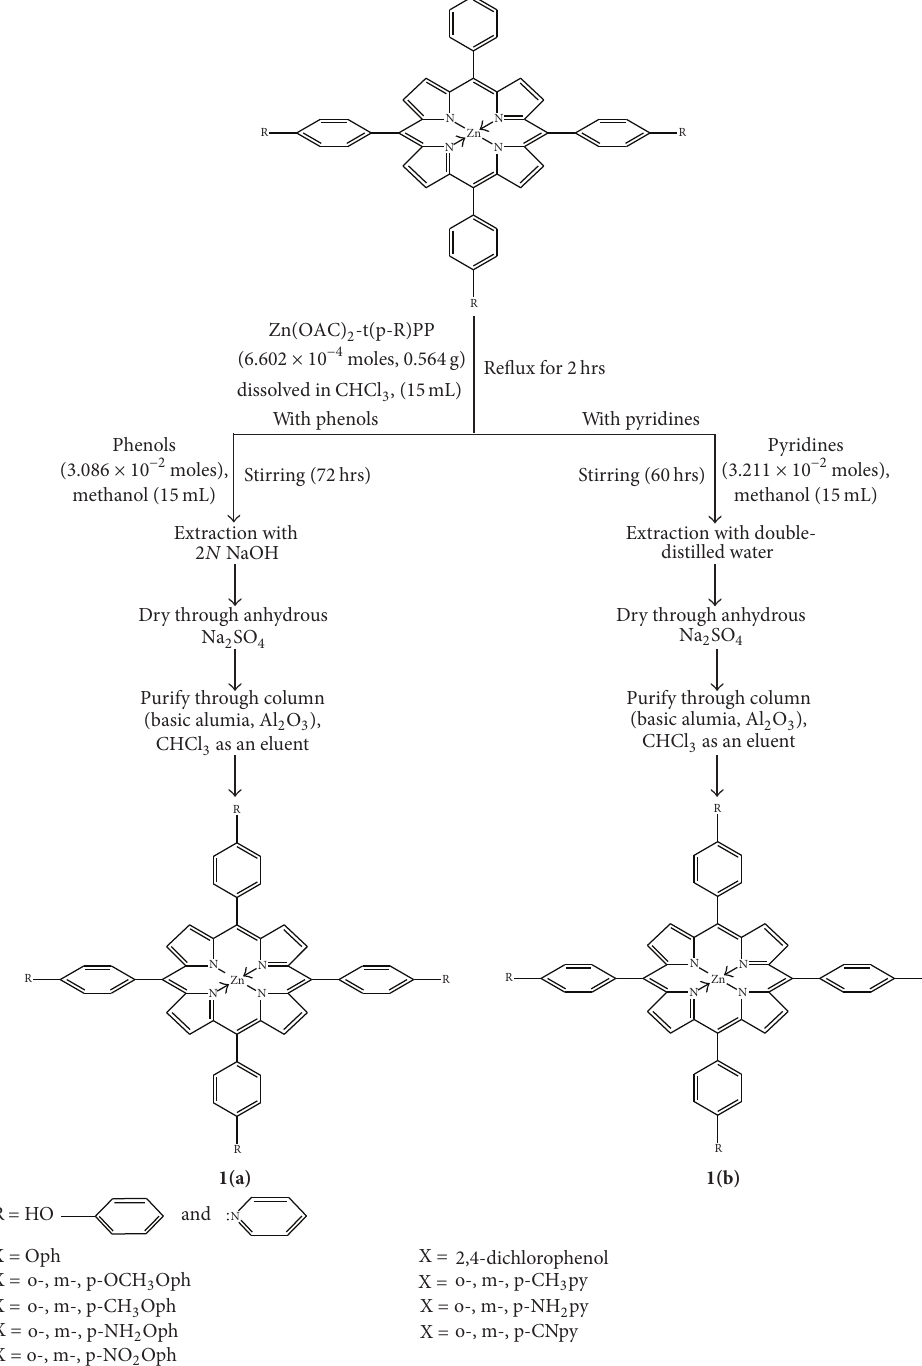
S 2: General scheme for the preparation of 5,10,15,20-meso-tetra(p-chlorophenyl)porphyrin zinc(II) containing different phenolates and pyridinates as axial